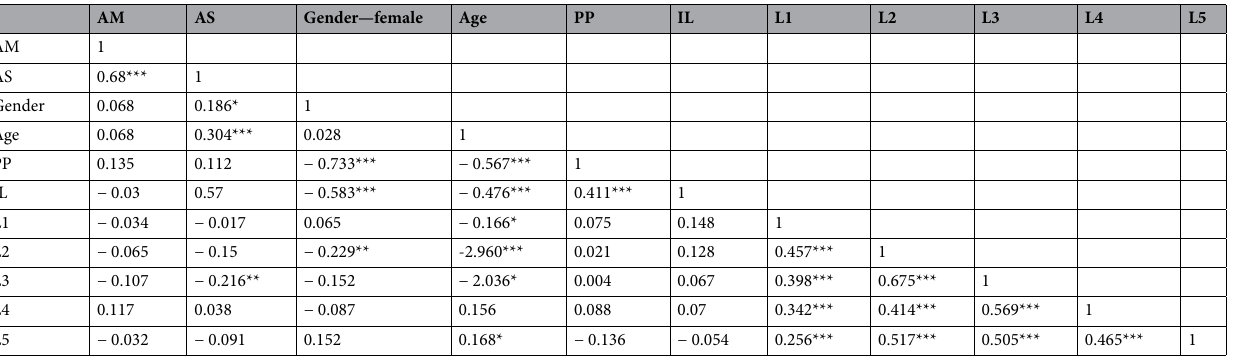
Table 5. Correlation of injury status (ASIA motor and sensory scores), psychosocial and physical wellbeing and independent living with level of willingness to participate in research. AM, ASIA motor score; AS, ASIA sensory score; IL, independent living score; PP, psychosocial and physical wellbeing score; L1, participation level 1— ‘opinion-based research involvement’ ; L2, participation level 2— ‘tissue donor involvement’ ; L3, participation level 3— ‘clinical trial involvement (without risk explained)’ ; L4, participation level 4— ‘ clinical trial involvement (without prior testing)’ ; and L5, participation level 5— ‘clinical trial involvement (with